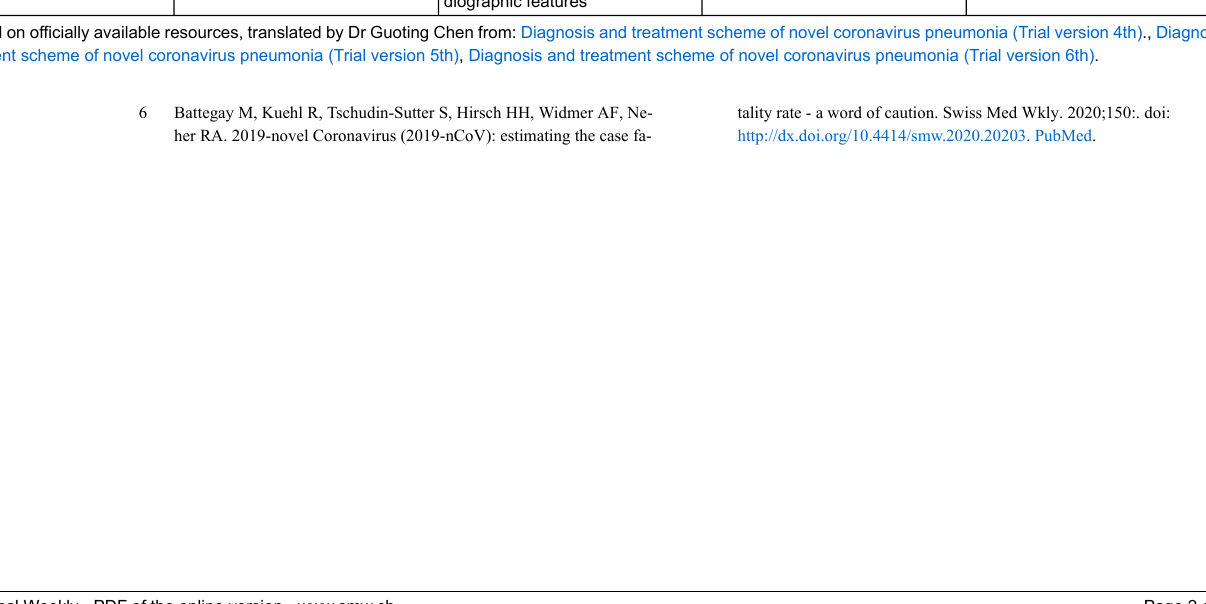
Table based on officially available resources, translated by Dr Guoting Chen from: Diagnosis and treatment scheme of novel coronavirus pneumonia (Trial version 4th)., Diagnosis and treatment scheme of novel coronavirus pneumonia (Trial version 5th), Diagnosis and treatment scheme of novel coronavirus pneumonia (Trial version